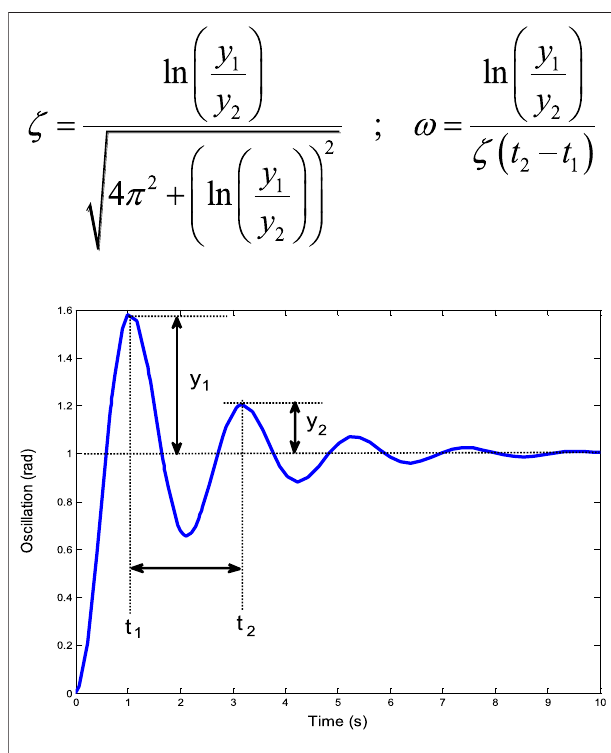
FIGURE 5 | The process of calculating the natural frequency and damping ratio from a response